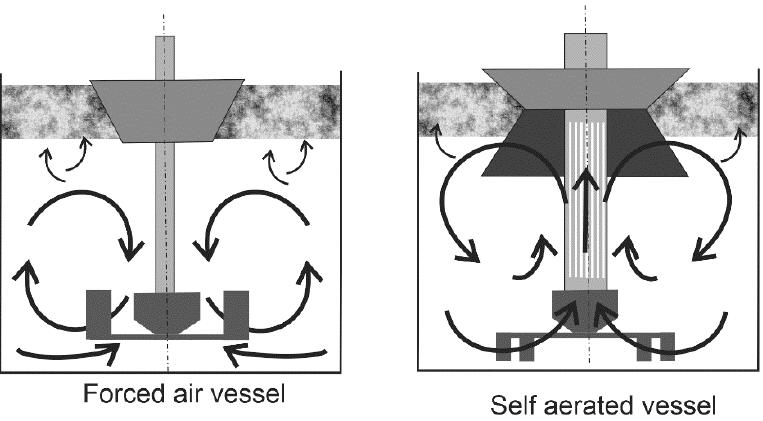
Figure 4. Mechanical flotation chamber.